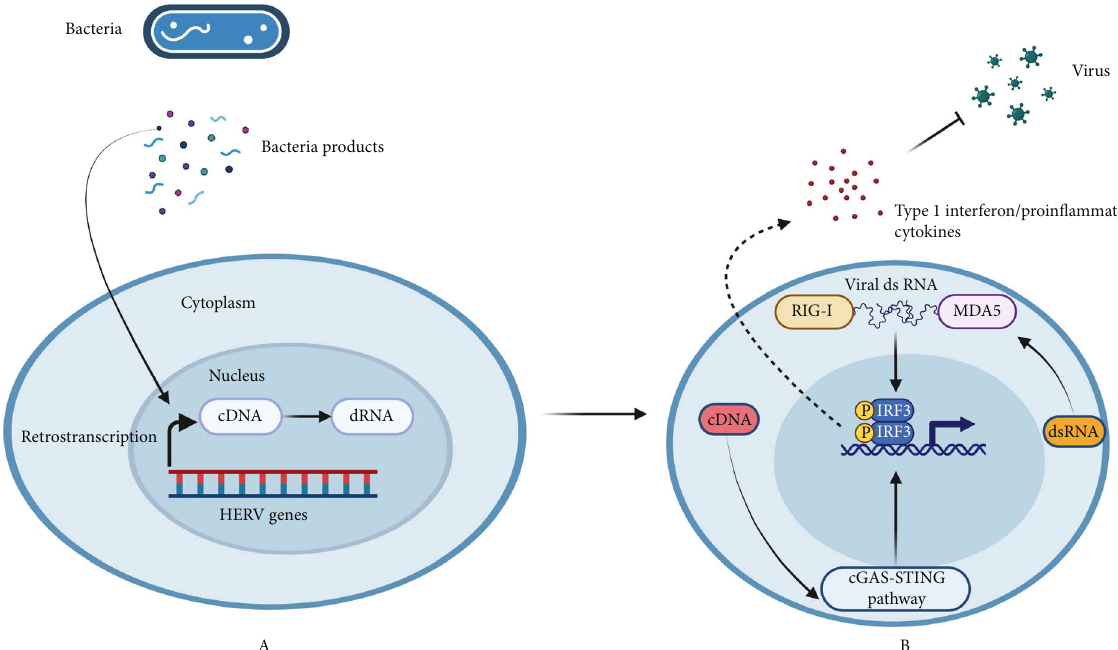
Figure 4: An illustration of retro-transcription of HERV (human endogenous retroviruses) or endogenous retroelements following stimuli released from commensal bacteria (a). Retro-transcription of human endogenous retroviruses (HERV) lead to the formation of cDNA and dsRNA that is released into the cytoplasm. The presence of cytosolic cDNA and dsRNA initiates a protective antiviral immune response via the activation of cGAS/STING and RIG-1/MAV pathways